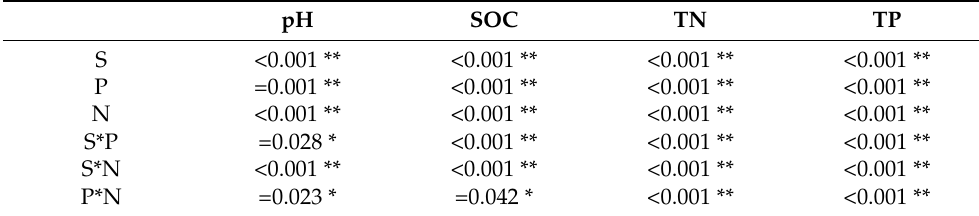
Table 1. Significance of the effects of different